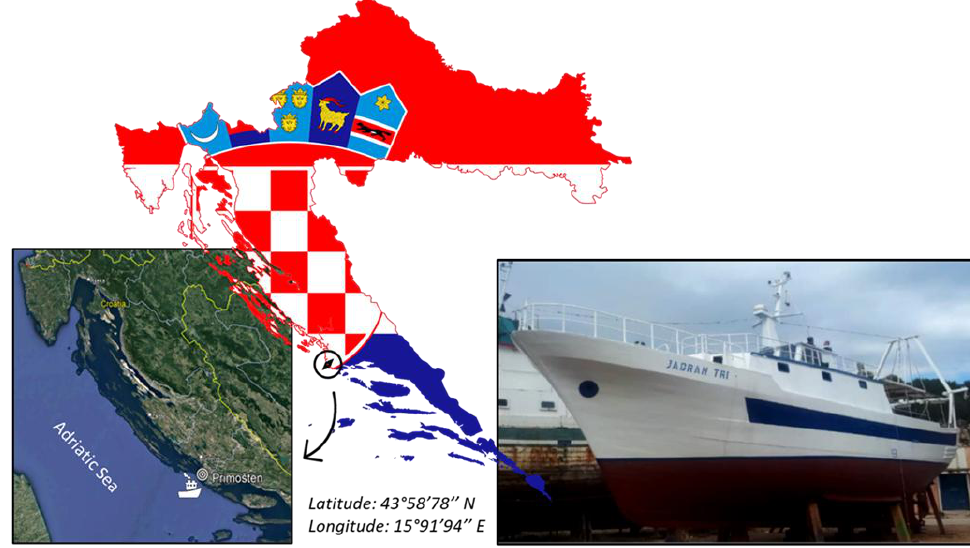
Figure 12. Operating location of the studied trawler. Table 3. Main particulars of the studied